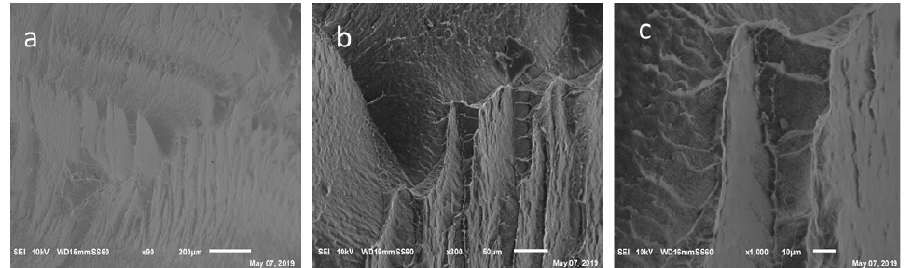
Figure 2. SEM Images of HDPE, CNC-ZnO composite at different magnifications: ( a) 90×, ( b) 300×, and ( c) 1000×.